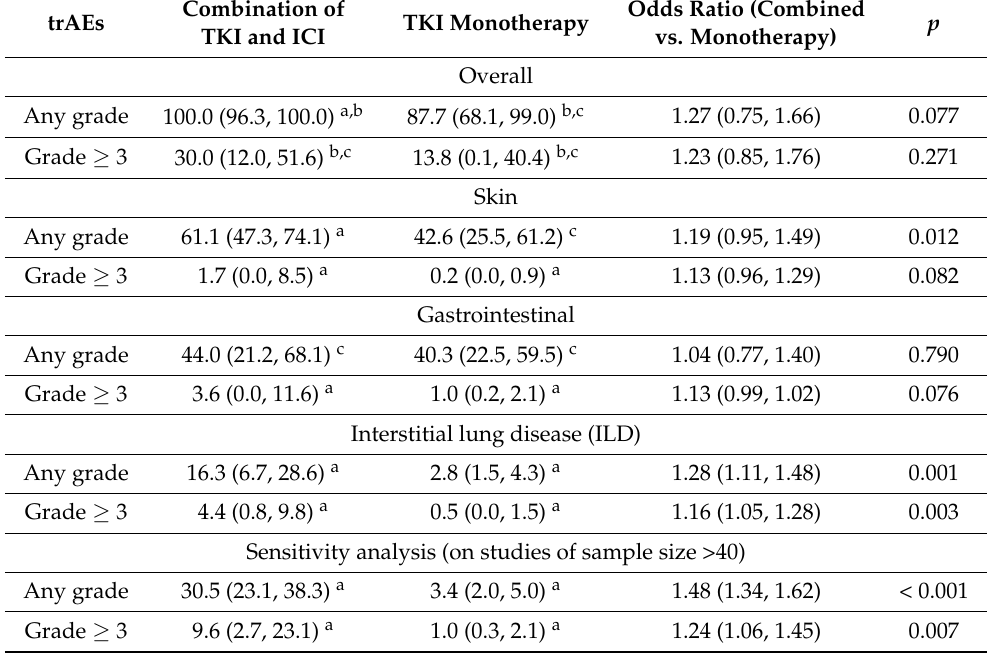
Table 3. Pooled incidence of trAE in combination epidermal growth receptor tyrosine kinase inhibitors and immune checkpoint inhibitors versus tyrosine kinase inhibitor